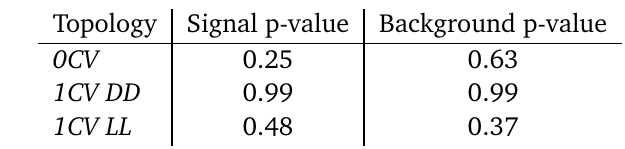
Table 4: Kolmogorov-Smirnov p-values for the comparison of the classifier’s distribu- tion between the test and training samples for the different